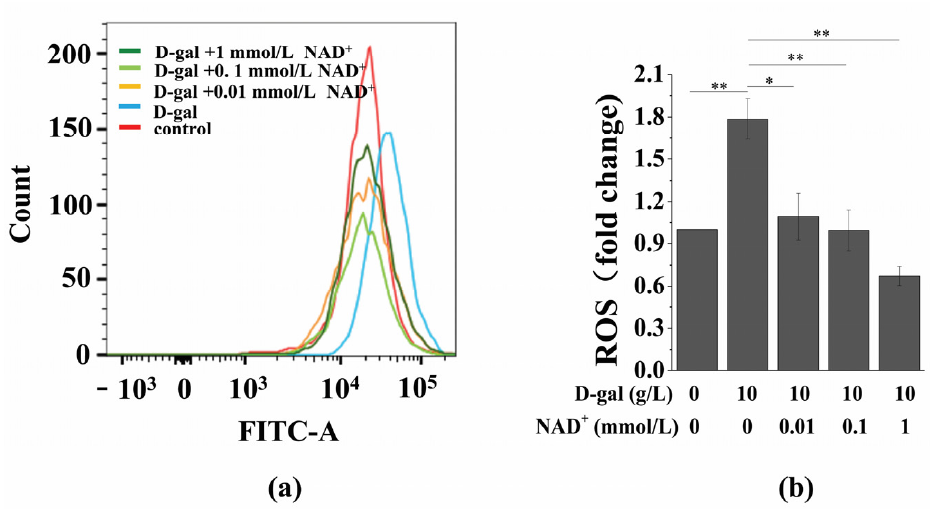
Figure 4. Exogenous NAD + downregulates intracellular ROS in senescent BMSCs. BMSCs were induced by 10 g/L of D ‐